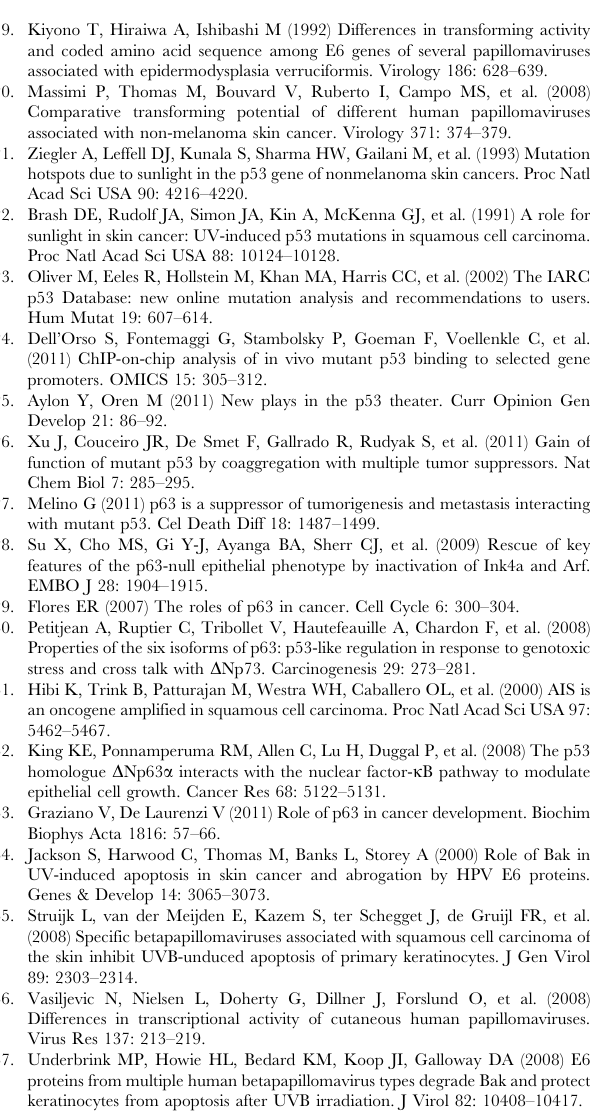
subsequently isolated and used for RT-PCR. GAPDH served as internal control. (TIF) Figure S2 HPV20E6 influenced neither the methylated nor unmethylated p16. Methylation status of the bisulfied p16 CpG islands was analysed by PCR amplification using primers specific for methylated or unmethylated p16. RKO was used as positive control of methylated p16. W (wild type) primers amplify only DNA which is not chemically modified and serve as a control for the efficiency of chemical modification. Gene expression was measured from three independent experiments and histograms represent unmethylated p16 normalized against wild type p16. No significant difference (student t-test) was determined between pLXSN-flag20E6 NIKS cells and the respective controls: (1) untransfected NIKS cells (2) pLXSN-NIKS cells (3) pLXSN- flag20E6-NIKS cells and (4) RKO cells. (TIF) Figure S3 HPV 20E6 up-regulated c-Jun and p-c-Jun protein levels. c-Jun and p-c-Jun levels in pLXSN-flag20E6 and